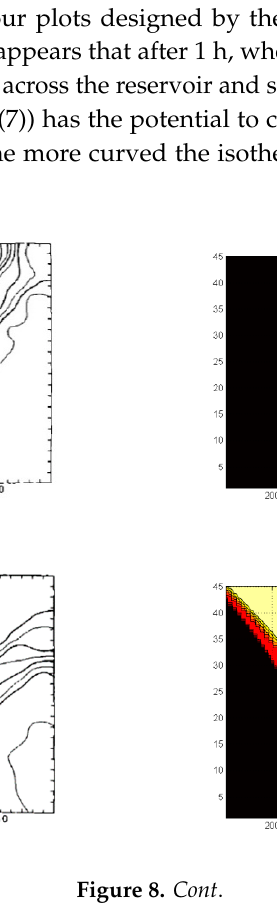
Figure 7. Variations in heat penetration depth, degree coefficient sin θ = reservoir with time.